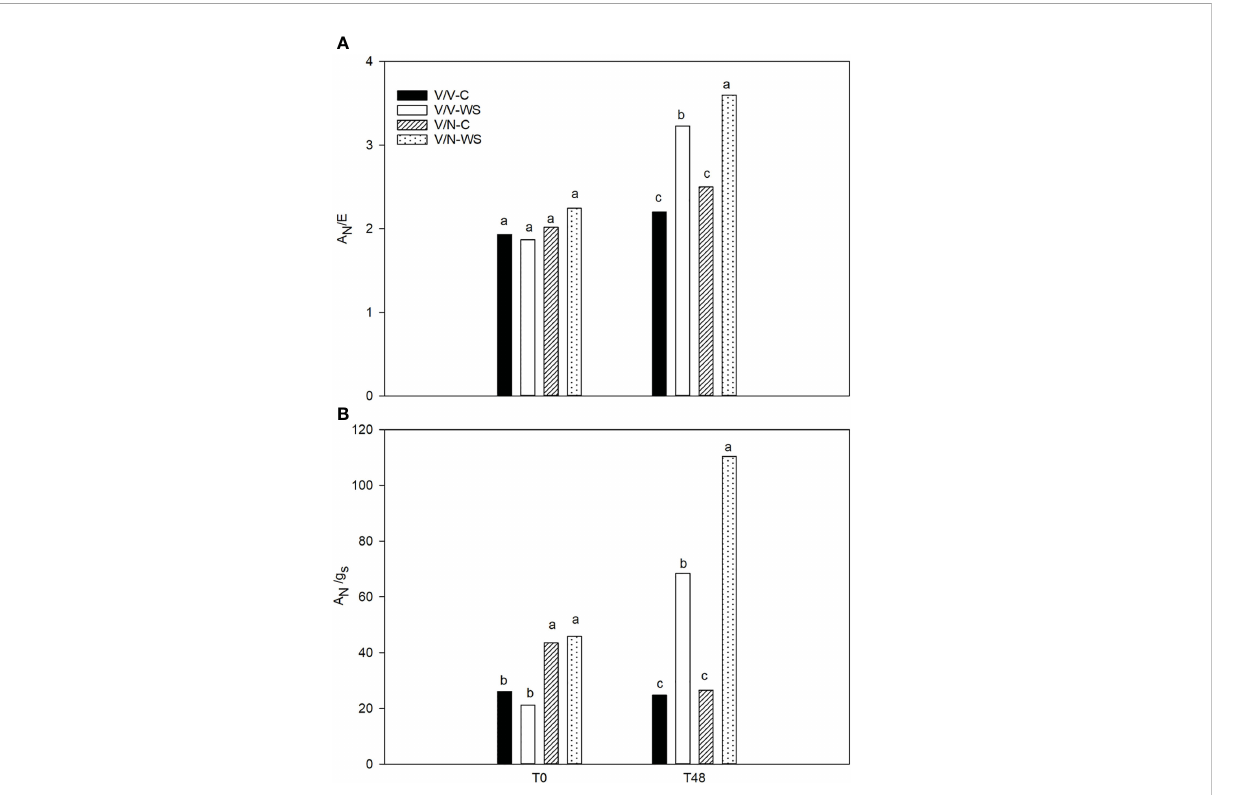
FIGURE 2 Instantaneous water use ef fi ciency (A N /E) (A) and intrinsic water use ef fi ciency (A N /g s ) (B) in the self-grafted pepper plants (V/V) and the plants grafted onto NIBER ® (V/N) at 0% PEG (control, C) or 5% PEG (water stress, WS). Measurements were taken on T0 and T48 (hours after treatment with PEG began). Data are the mean values for n = 4. For each studied time, different letters indicate signi fi cant differences at P ≤ 0.05 (LSD